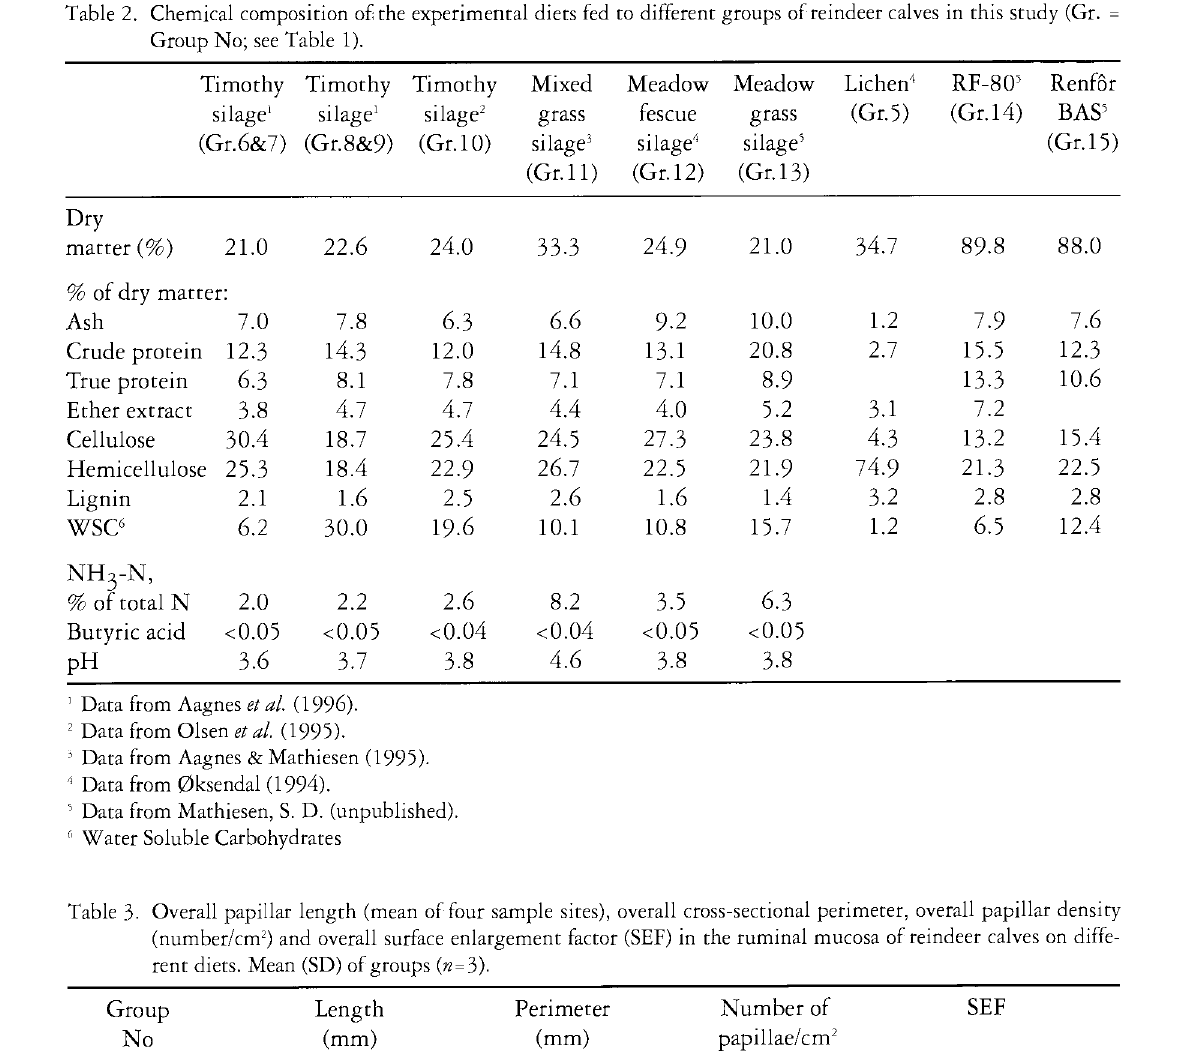
Table 2. Chemical composition of the experimental diets fed to different groups of reindeer calves in this study (Gr. = Group No; see Table 1).